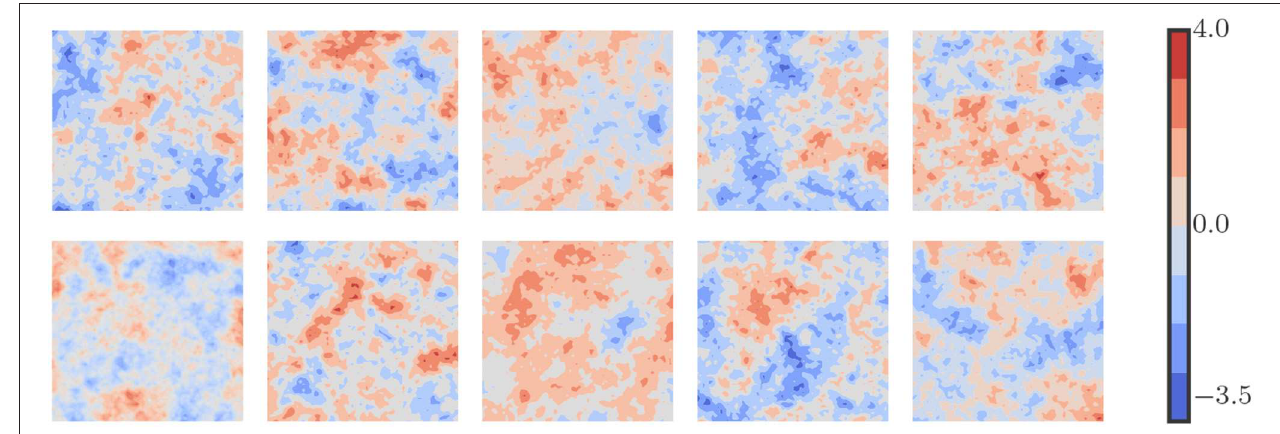
FIGURE 2 | Sample plots of log-permeability field. Uncertain permeability field is modeled from a log-normal distribution function with zero mean and exponential covariance.